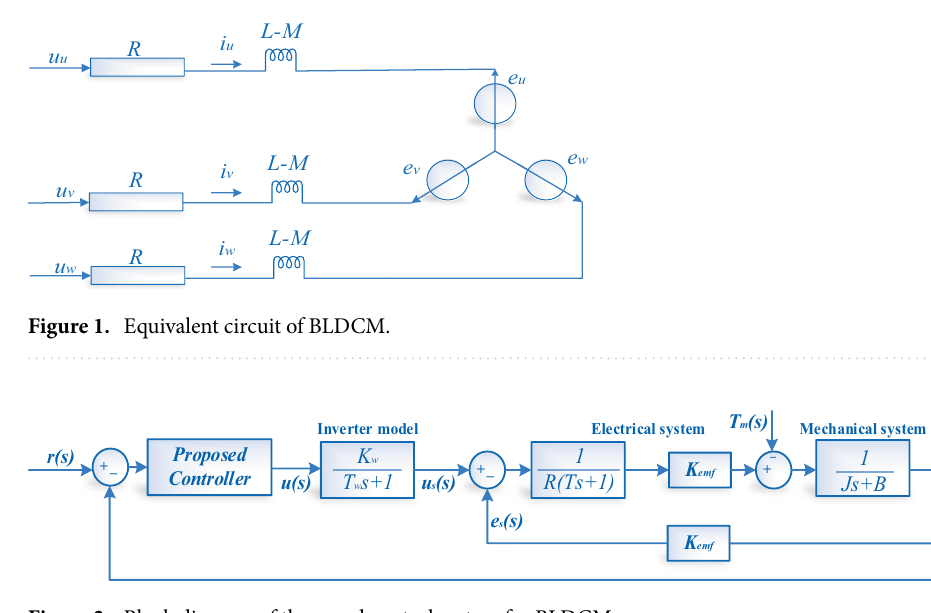
Figure 2. Block diagram of the speed control system for BLDCM.